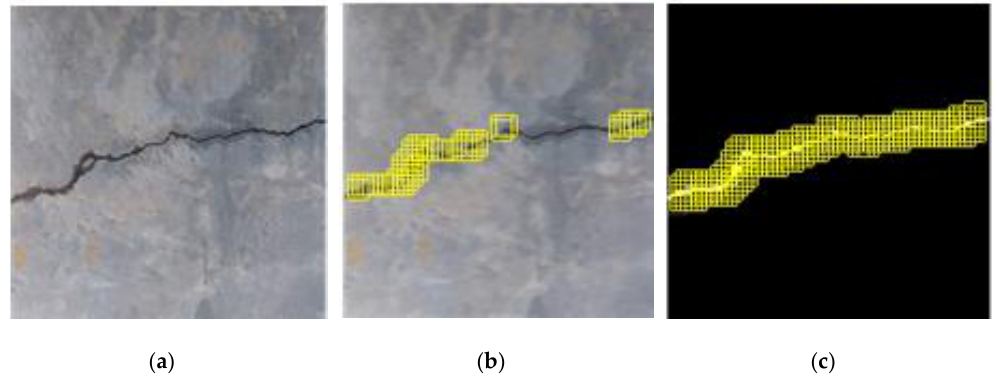
Figure 22. ( a ) Original crack images, and the results of crack position detection (CPD) based on ( b ) the original CPD and ( c ) the MLP–CNN, under the influence of blurs.